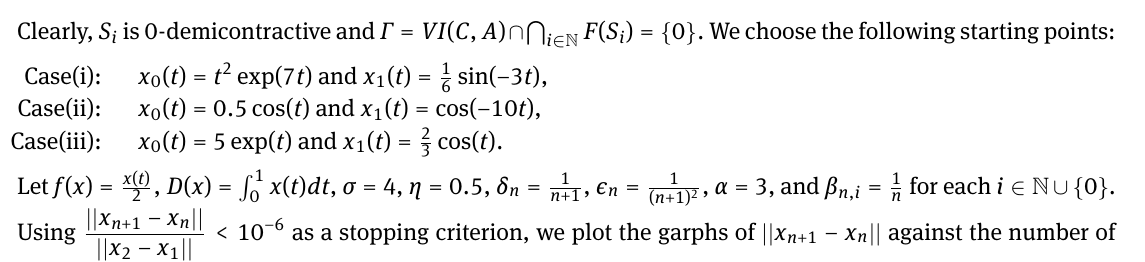
Algorithm 3.1 THSEgM(I)